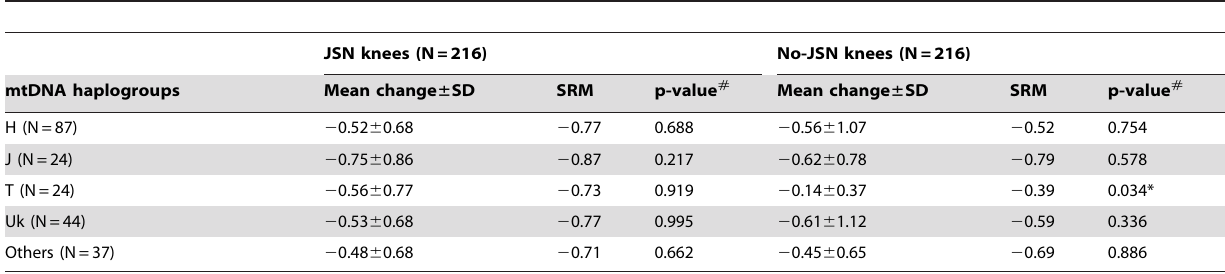
Table 3. Mean differences in mJSW change over 4 years at minimum mJSW among the mitochondrial DNA (mtDNA) haplogroups in 216 OA